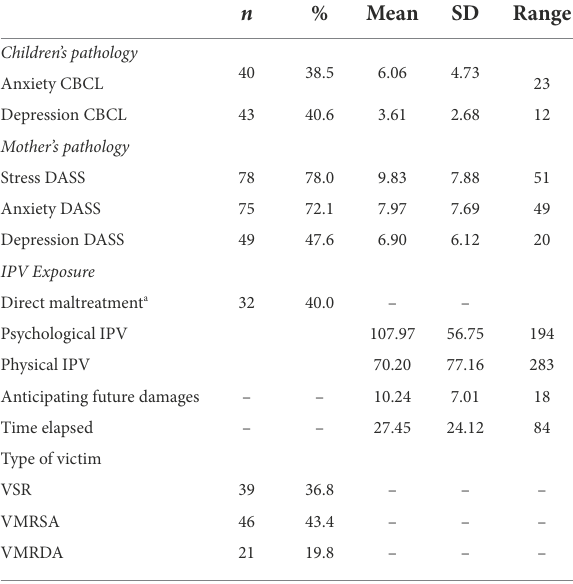
TABLE 1 Descriptive statistics of study